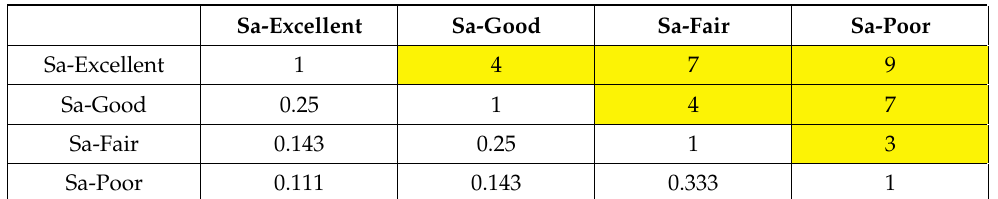
Table 10. PCM for the Safety Criterion.